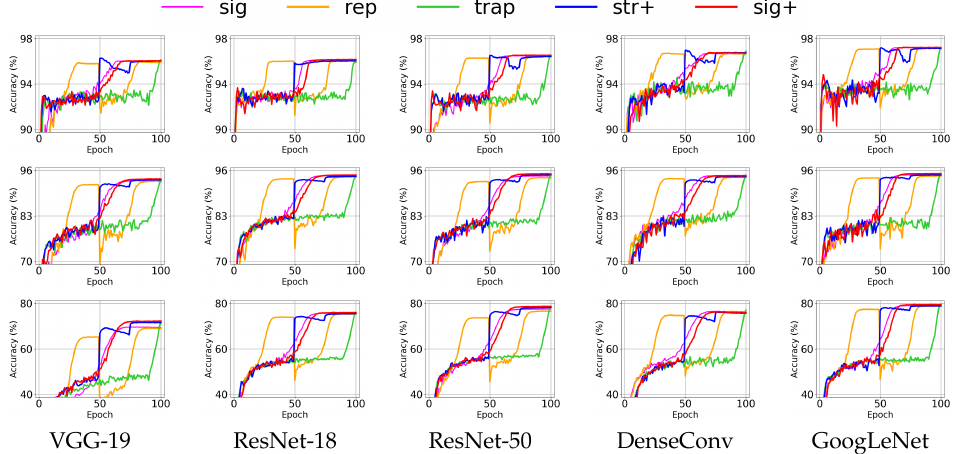
Figure 5. DNNs with learning rate warmup. Accuracy curve over epochs for SVHN ( top row ), CIFAR-10 ( middle row ), and CIFAR-100 ( bottom row ) by SGD with different learning rate annealings: sigmoid function without warmup (sig), twice-repeated sigmoids (rep), trapezoid with 10%-epoch warmup (trap), staircase with the warmup (str+), and our sigmoid with the warmup (sig+): Per-epoch average of validation accuracy over 10 trials is shown in the y-axis where the range of accuracy is fixed for each data-set. Epoch (0, 1, 2, ..., 100) is shown in x-axis.